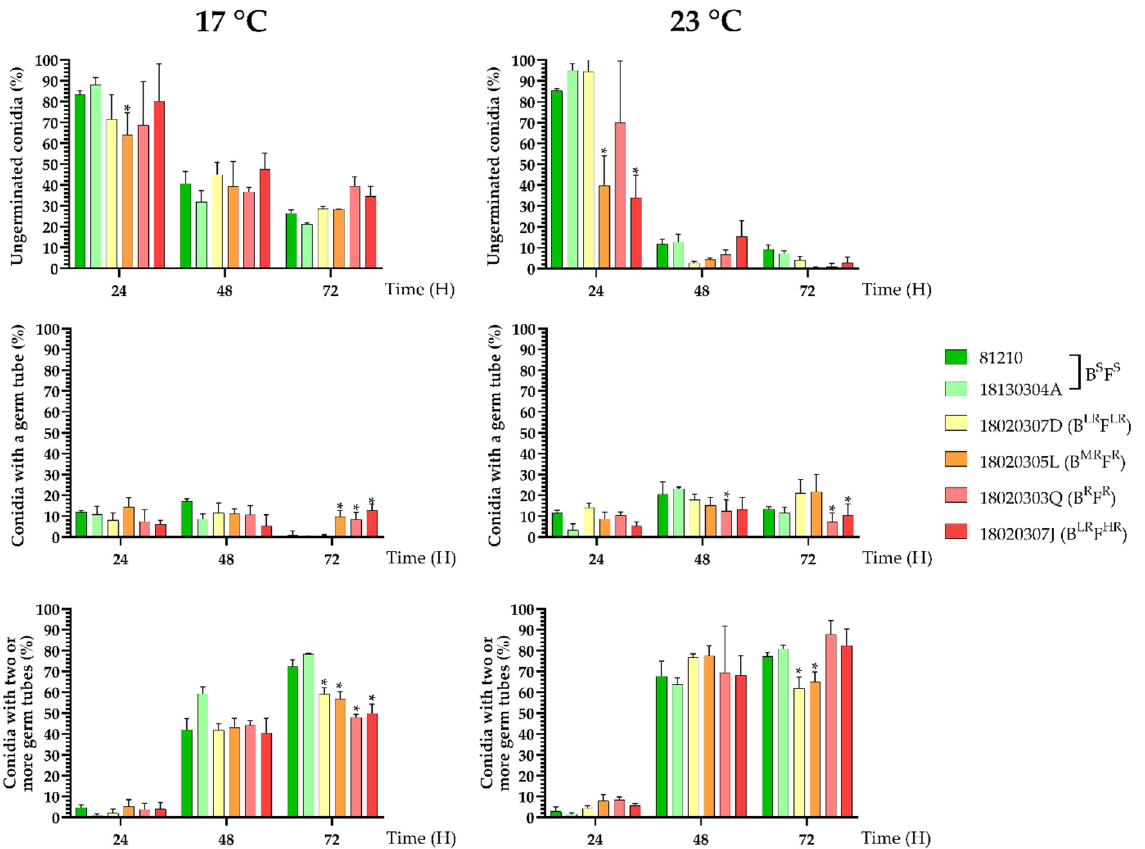
Figure 2. Percentage of ungerminated conidia, conidia with germ tube and conidia with two or more germ tubes incubated at 17 °C and 23 °C for 24, 48 and 72 h. P. xanthii isolates with different SDHI phenotypes (sensitive and low resistance, moderate resistance, resistant and high resistance to boscalid or fluopyram) were tested. For significantly different values, * is showed on the column.